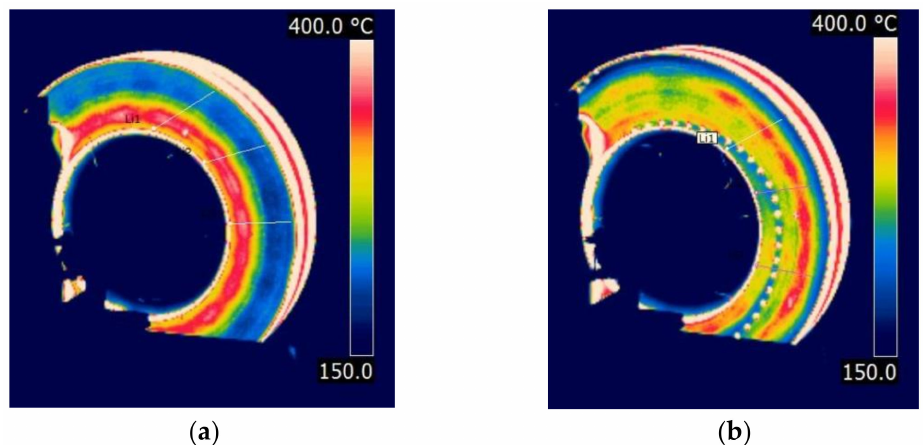
Figure 9. Temperature distribution on a disc at the moment braking ended from a speed of 200 km/h: ( a ) classic (smooth), ( b ) perforated on the friction